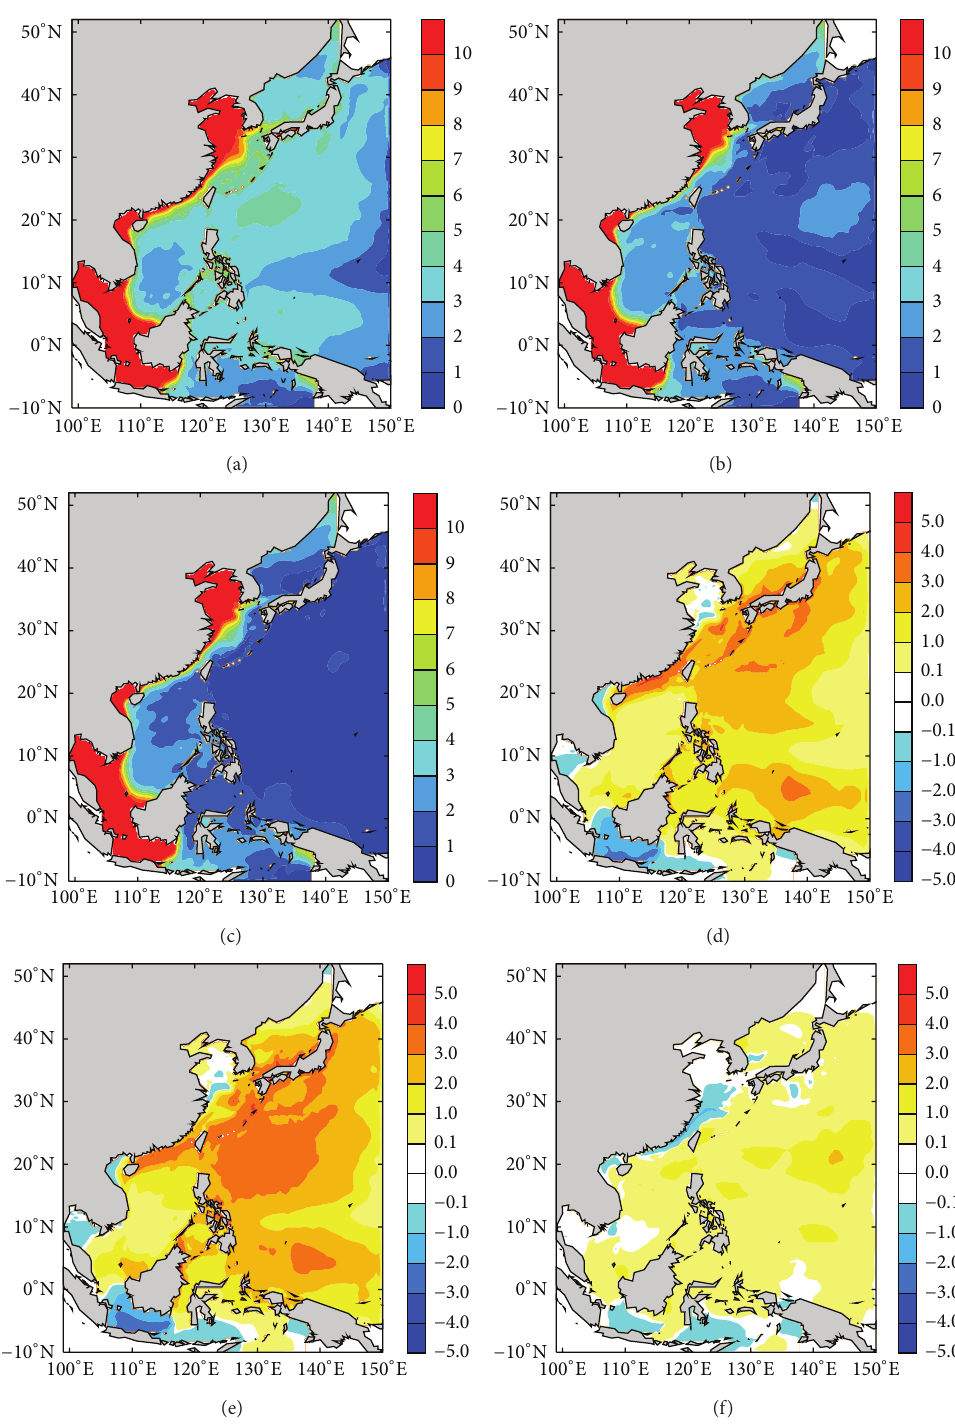
Figure 2: (a), (b), and (c) show the horizontal distribution of vertical averaged temperature RMSEs of three twin-experiments, respectively, using (2); (d) shows the difference of temperature RMSEs between Experiments 2 and 1, that is, Experiment 1 minus Experiment 2, and (e) is for Experiment 1 minus Experiment 3; (f) is for Experiment 2 minus Experiment 3. Unit: ∘ C. Experiment 1 is a free run where no data is assimilated, while Experiment 2 only assimilates “conventional observations” and Experiment 3 assimilates all the “observations” including “conventional observations” and “Argo